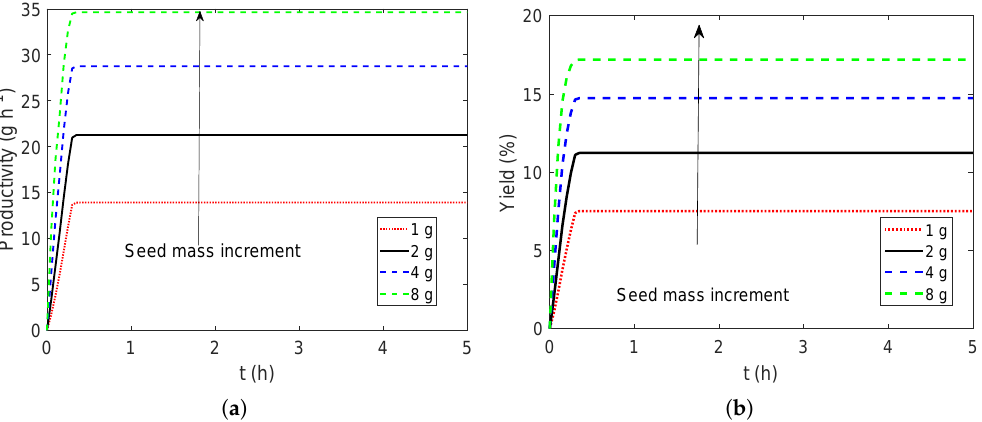
Figure 9. Effect of the seed mass on—( a ) productivity and ( b ) yield of the process. The exchange location is kept as the midpoint along the PFC. Both the productivity and yield increase with the increase in seed mass as it increases the available surface area for crystal